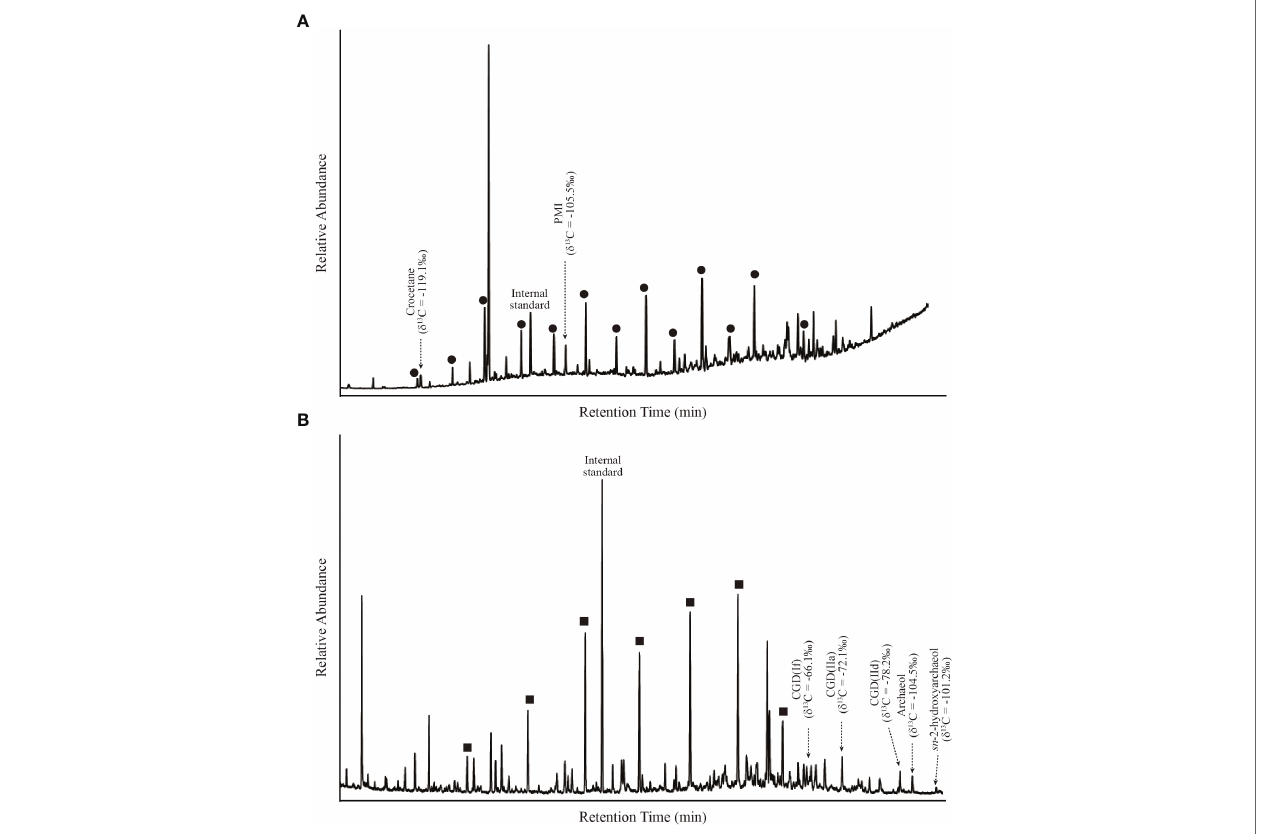
FIGURE 6 | Gas chromatograms of the total lipid extracts from MDAC (1.16 mbsf at Site ARA07C-St 13); (A) n- alkanes, and (B) straight-chain